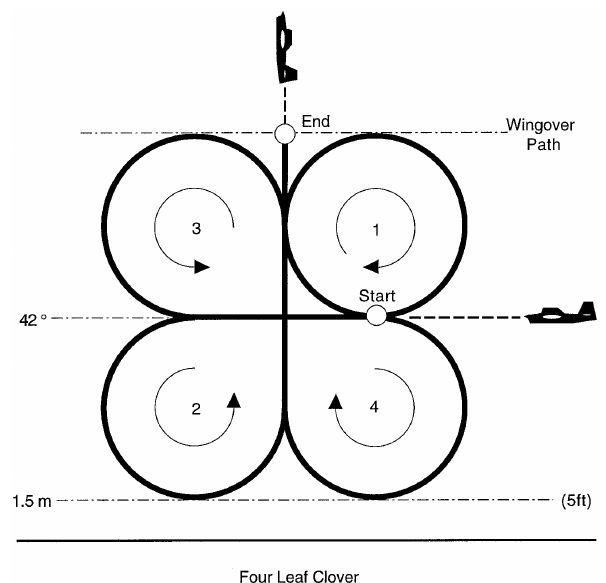
Figure 12. Maneuver model performed by the aircraft in the clove- leaf test (source: modified from https://www.ibiblio.org/hyperwar/ USN/ref/ASW-Convoy/ASW-Convoy-2.html, free